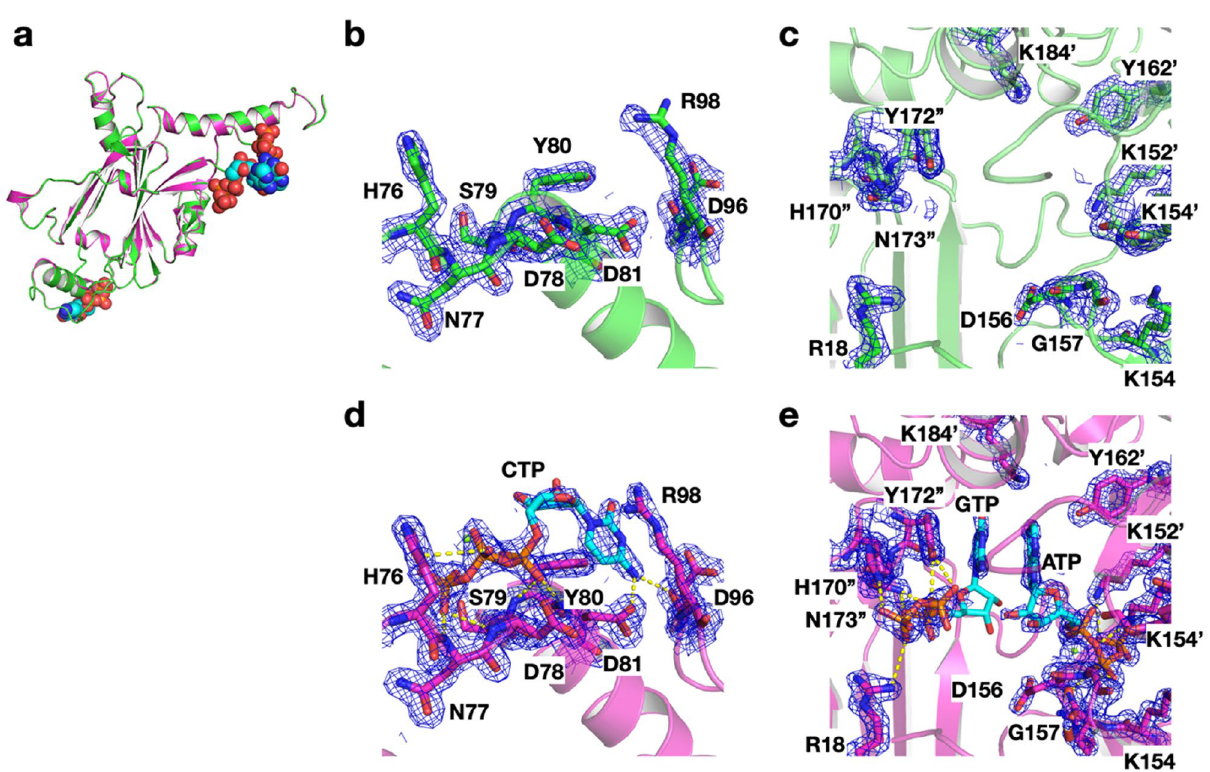
Figure 4. Comparison of crystal structure between PhC_CF 20°C/24h and PhC_IC (PDB ID: 5gqm) 28 . ( a ) Superimposed structures of PhC_CF 20°C/24h (green) and PhC_IC (magenta). ( b , c ) Close-up views of ( b ) CTP and ( c ) ATP/GTP binding sites in PhC_CF 20°C/24h , ( d , e ) Close-up views of ( d ) CTP and ( e ) ATP/GTP binding sites in PhC_IC. The selected 2| F o | − | F c | electron-density maps at 1.0σ are shown in bule. Hydrogen bonds are indicated with yellow dotted